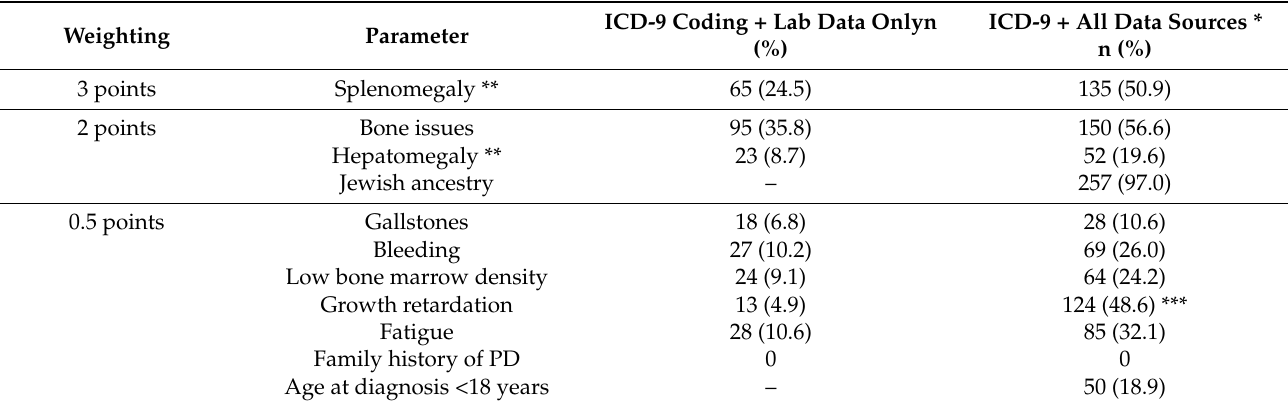
Table 3. Application of the GED-C scoring system to patients with confirmed Gaucher disease: non-laboratory items.